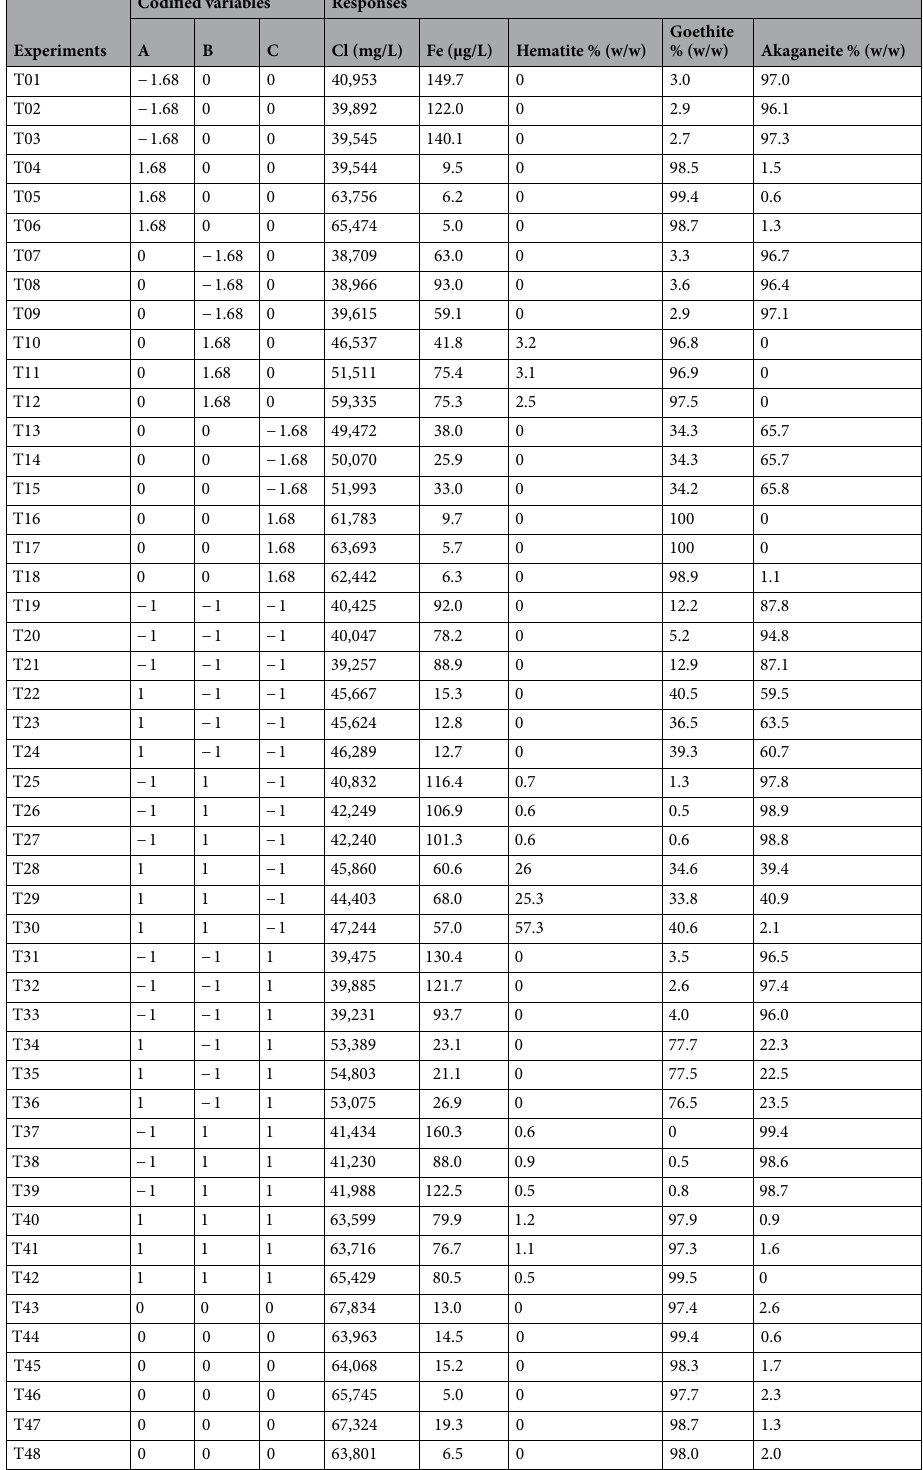
Table 5. Design matrix and results of the central composite optimization